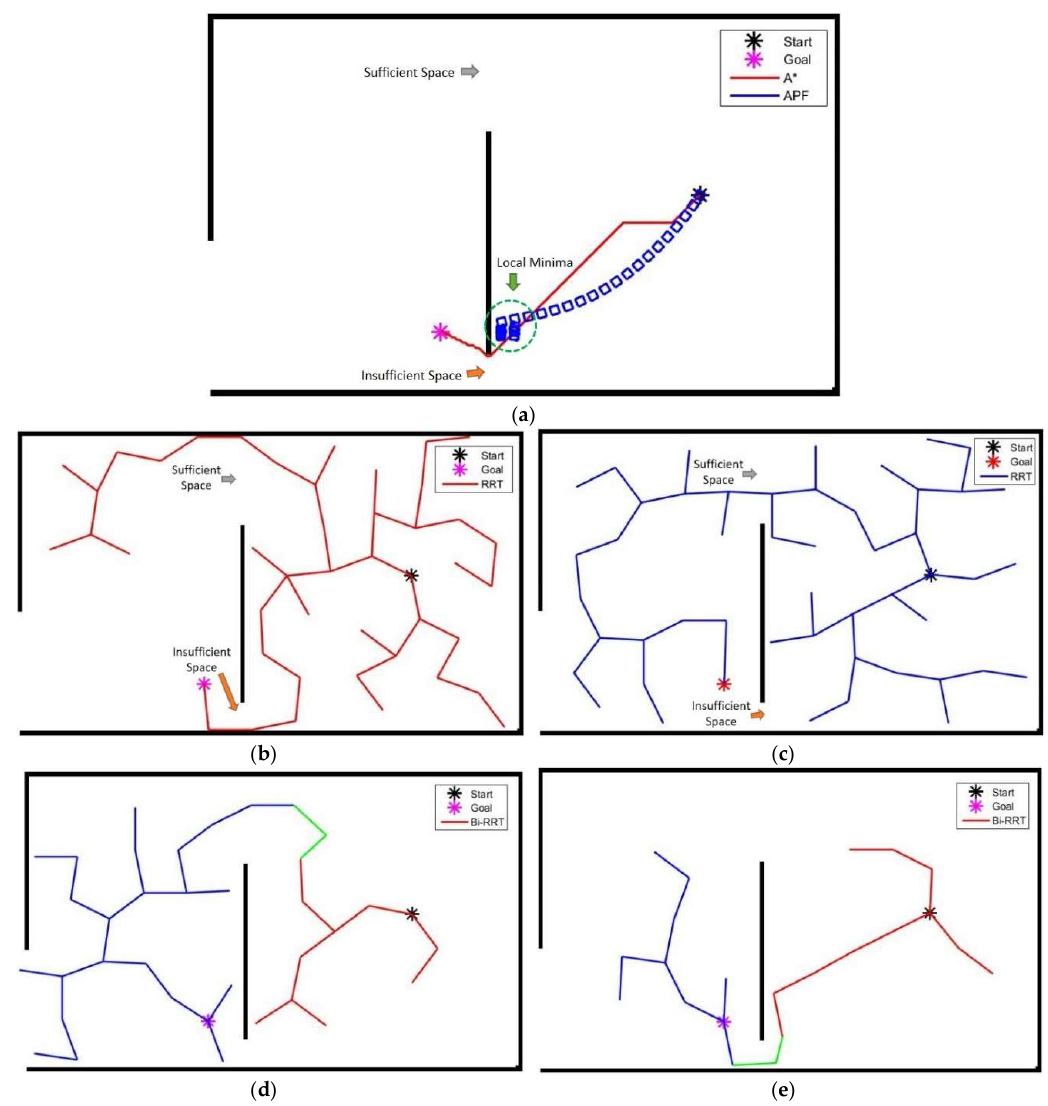
Figure 11. Generated path, for Dataset I, using: ( a ) A* algorithm and APF method; ( b ) first iteration of the RRT algorithm; ( c ) second iteration of the RRT algorithm; ( d ) first iteration of the bidirectional RRT algorithm; and ( e ) second iteration of the bidirectional RRT algorithm.